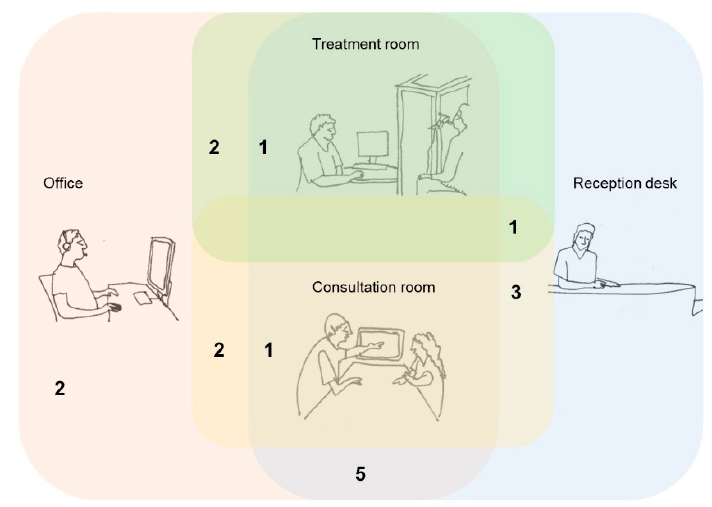
Figure 5. Overlap of workplaces of the participants.